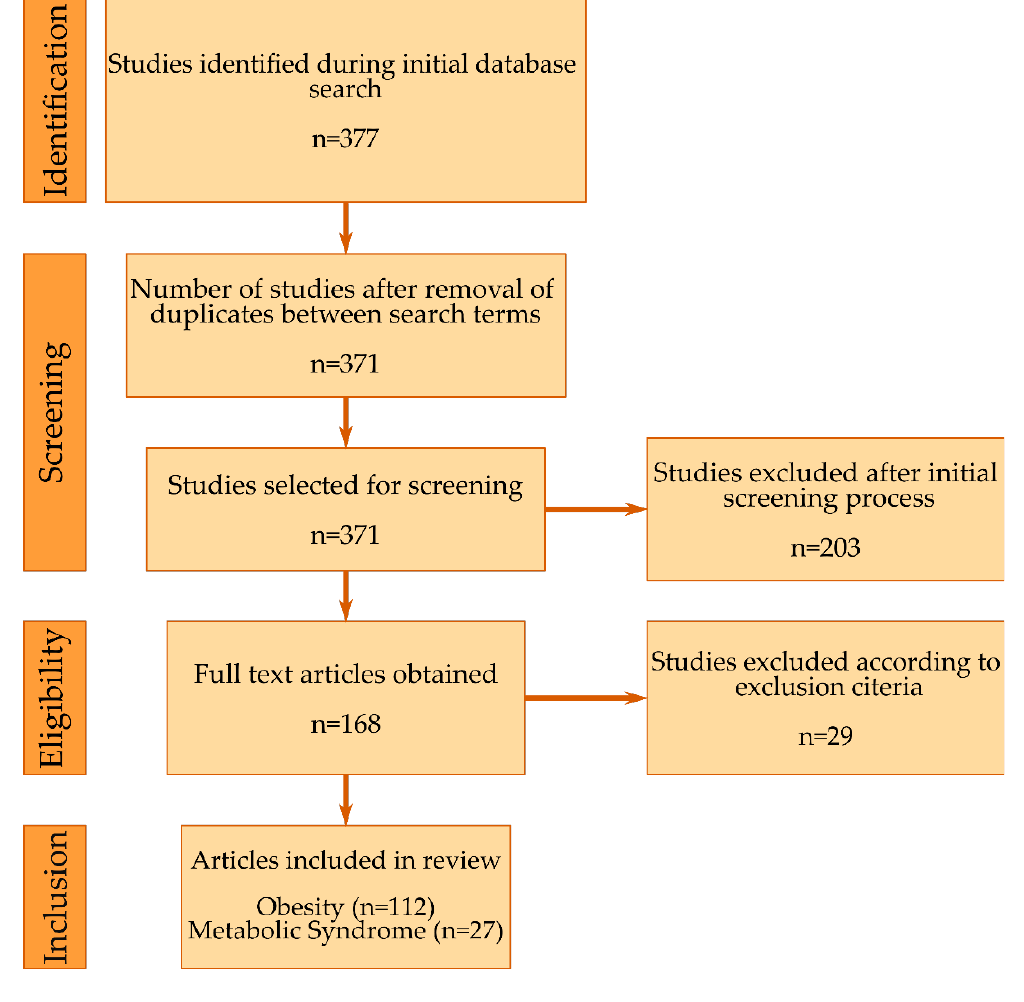
Figure 2. Flow diagram for the identification, selection, and inclusion process.